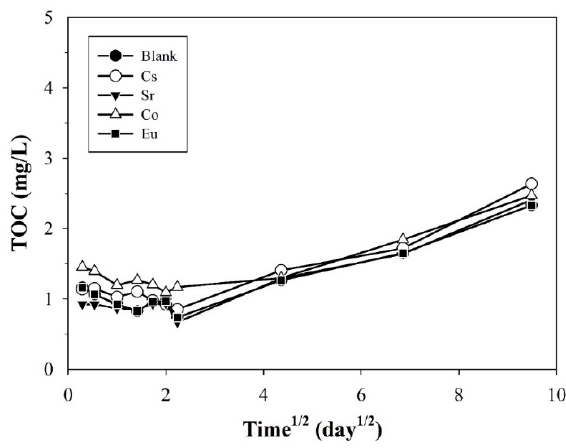
Figure 4. TOC in the leachates as a function of elapsed time.